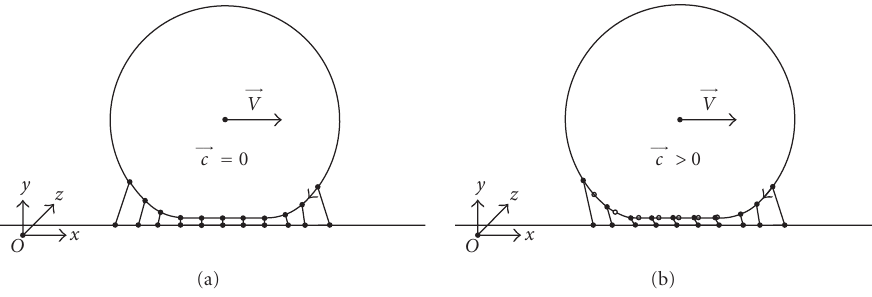
Figure 4: The case of rolling without slip (a) and rolling with slip